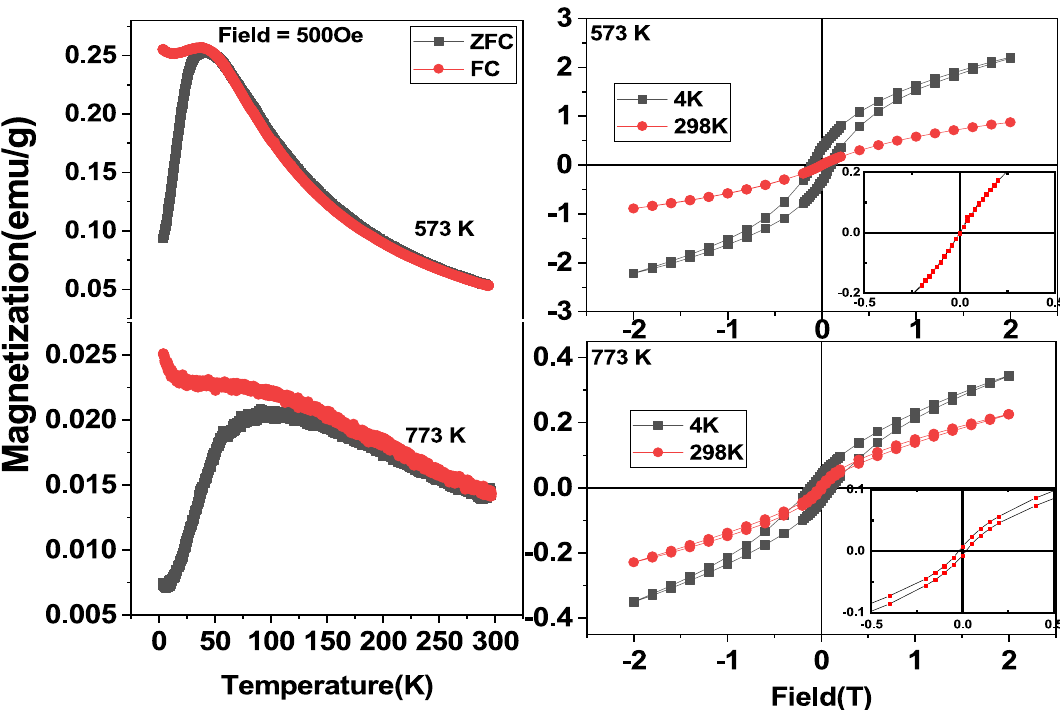
Figure 3. Temperature and magnetic field dependence of magnetization are shown corresponding to the precursor calcined at 573 K and 773 K. Variation of magnetization in terms of ZFC and FC with temperature corresponding to the precursor calcined at 573 and 773 K are shown. Variation of magnetization with the applied magnetic fields is shown in the right panel corresponding to the precursor of the sol–gel reaction subjected to calcination at 573 K and 773